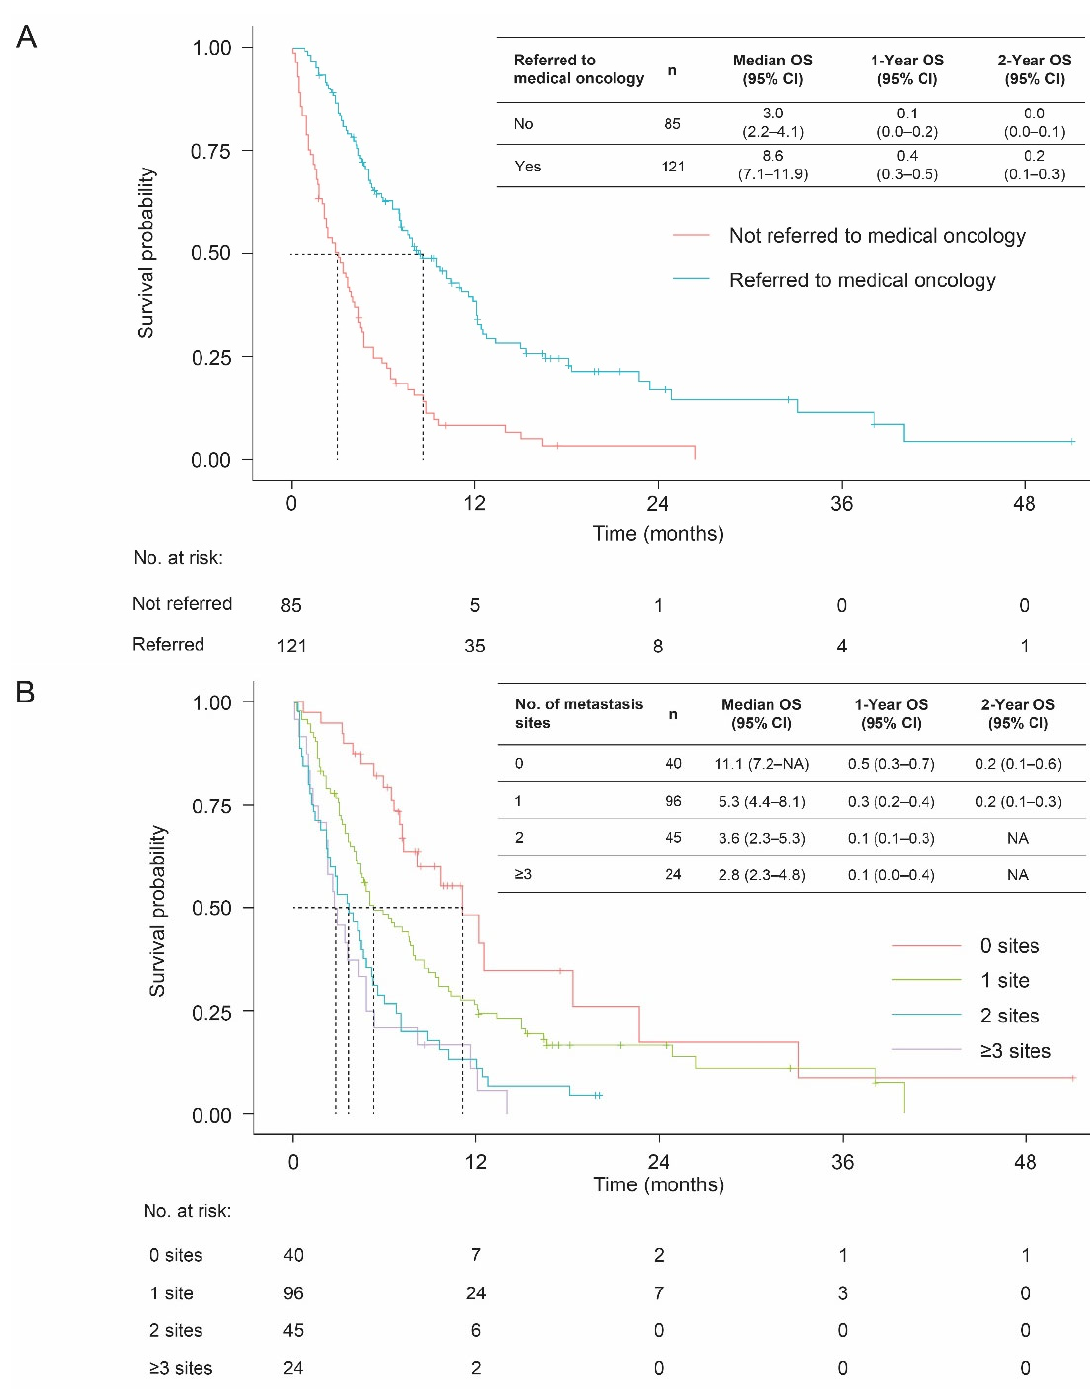
Figure 3. OS from diagnosis among patients with de novo la/mUC according to ( A ) referral status and ( B ) number of metastasis sites. Abbreviations: CI, confidence interval; la/mUC, locally advanced or metastatic urothelial carcinoma; NA, not available; OS, overall survival.